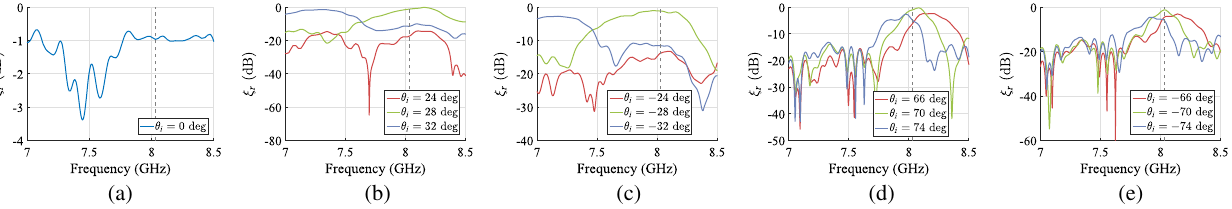
FIG. 12. Measured reflection efficiency of the five-channel isolating mirror when illuminated from (a) port 3, (b) port 4, (c) port 2, (d) port 5, and (e) port 1. The dashed line shows the operating frequency.